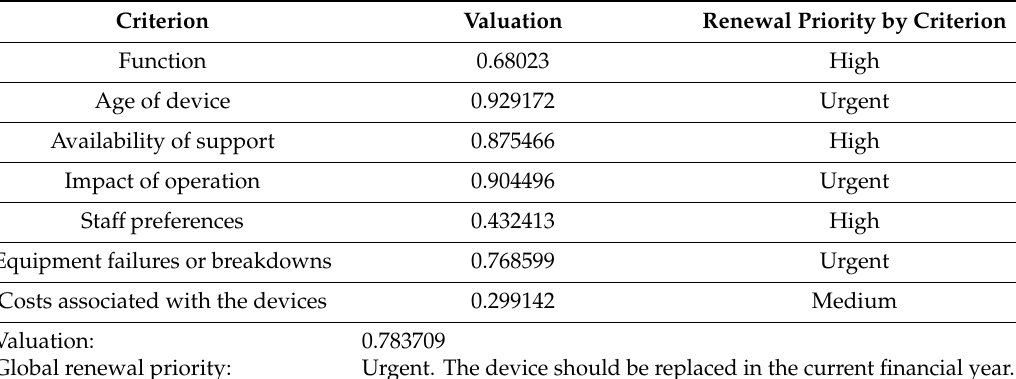
Table 26. Results for the